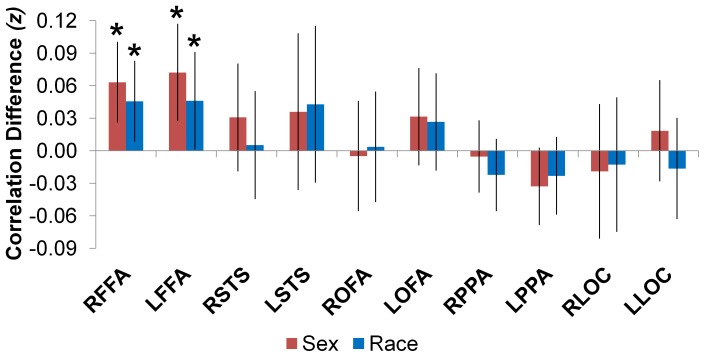
Bar graphs display mean correlation differences expressed in z-scores (same-sex>different-category in red, same-race>different-category in blue).An asterisk denotes a correlation difference that is reliably greater than zero across participants, p<.05. Error bars represent 95% confidence intervals in within-subject comparisons [39]. R and L as the first letters of a region-of-interest’s (ROI) acronym denote the brain hemisphere in which the ROI is localized. FFA = fusiform face area, OFA = occipital face area, STS = superior temporal sulcus, PPA = parahippocampal place area, LOC = lateral occipital complex.